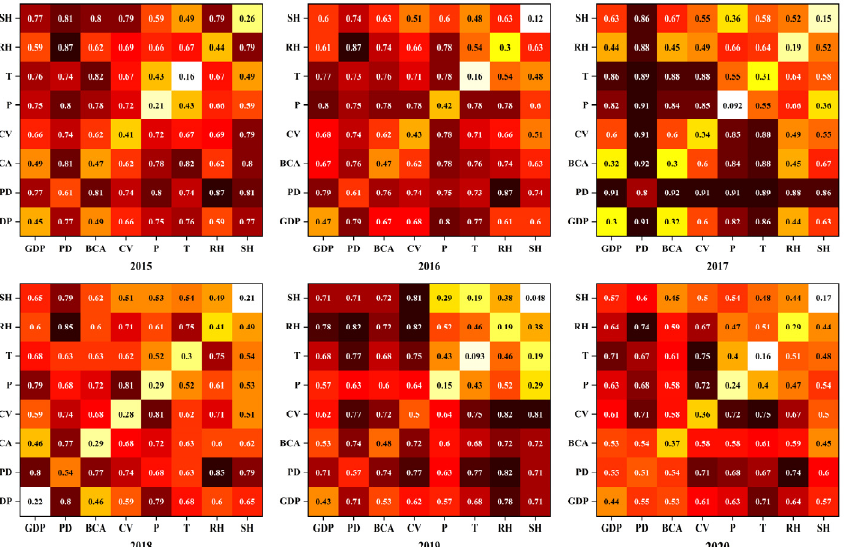
Figure 11. Interactive change characteristics of driving factors in Yunnan from 2015 to 2020 (RH: relative humidity; SH: sunshine hours; P: precipitation; T: temperature; PD: population density; BCA: building construction area; GDP: gross domestic product; CV: civilian vehicle).